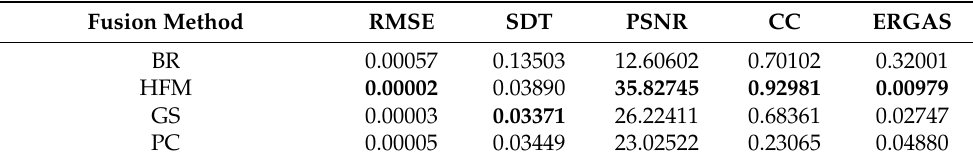
Table 1. Results of statistical indicators implemented to measure quality in fusion methods: Brovey (BR), high-frequency modulation (HFM), Gram–Schmidt (GS), and principal components